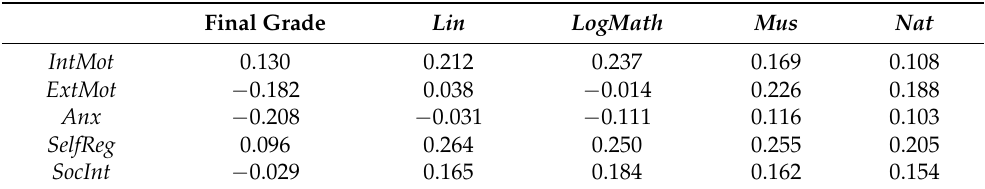
Table 9. Correlations table for SRLAS versus MI